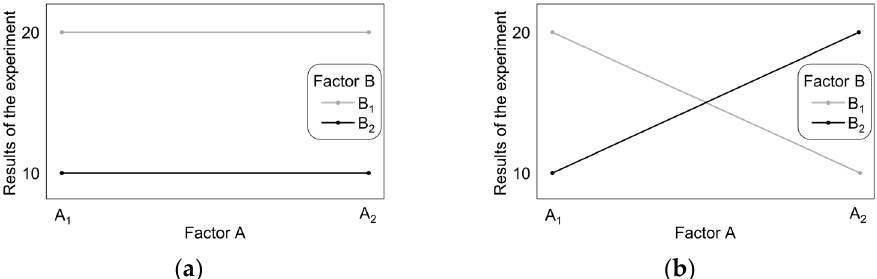
Figure 1. Interaction graph for experiment T 1 : ( a ) no interaction between factors A and B and ( b ) interaction of factors A and B.